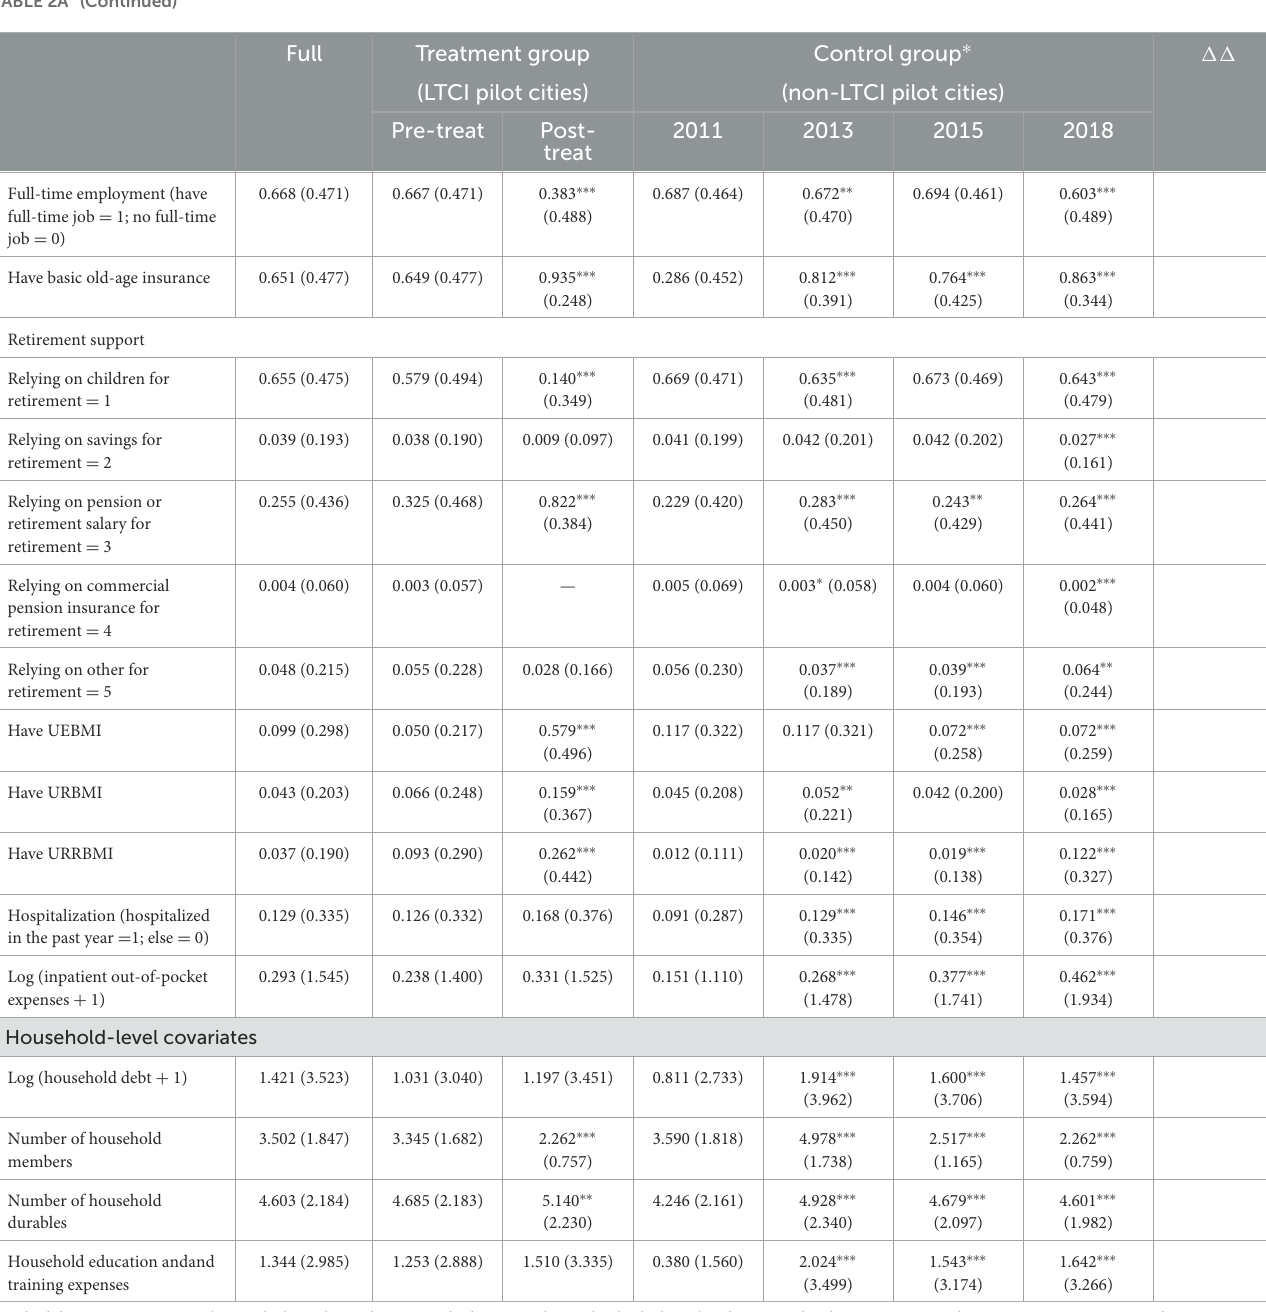
Table 2A. σ t is a year-fixed effect and ε c term. Standard errors are clustered at the city level to account for possible correlations between middle-aged and older adults in the same